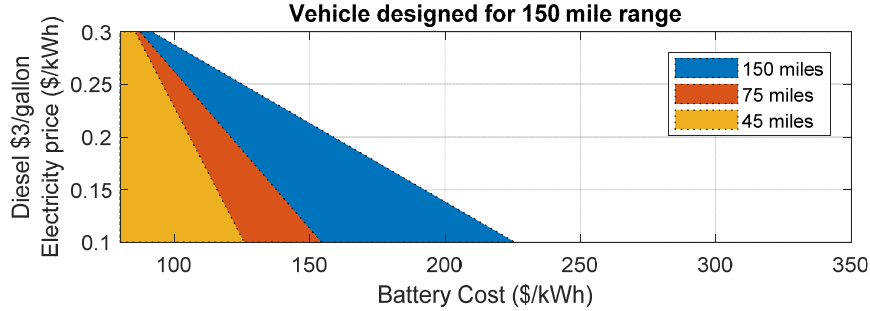
Figure 6. TCO parity check for class4 delivery truck with reduced VMT. The shaded regions represent the lines represent the conditions where the electric truck has a lower TCO over the diesel counterpart.